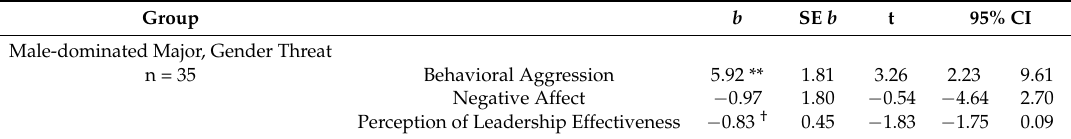
Table 3. Multiple multivariate regression analysis of factors related to self-reported